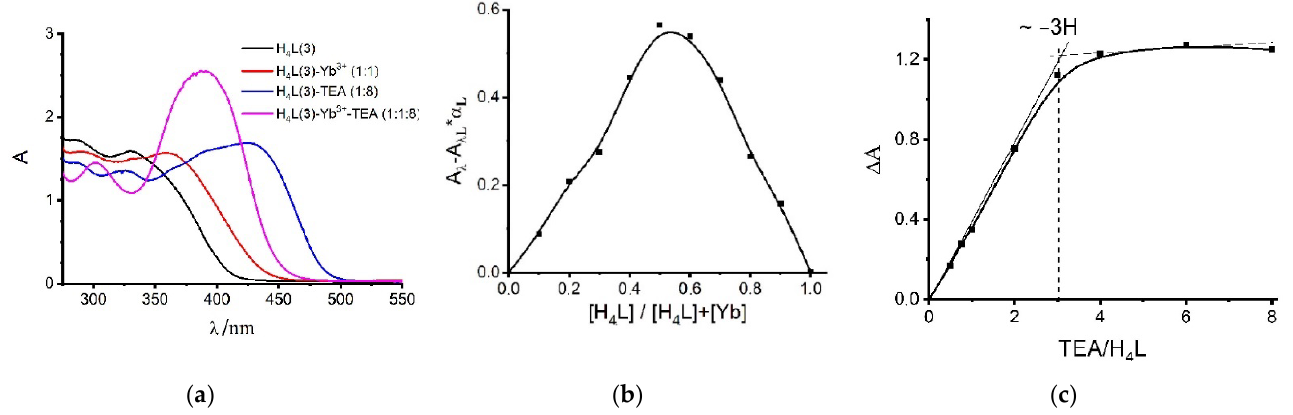
Figure 6. ( a ) UV-Vis absorption spectra of H 4 L( 3 ) (C L = 0.05 mM) in DMF; H 4 L( 3 ) with Yb(NO 3 ) 3